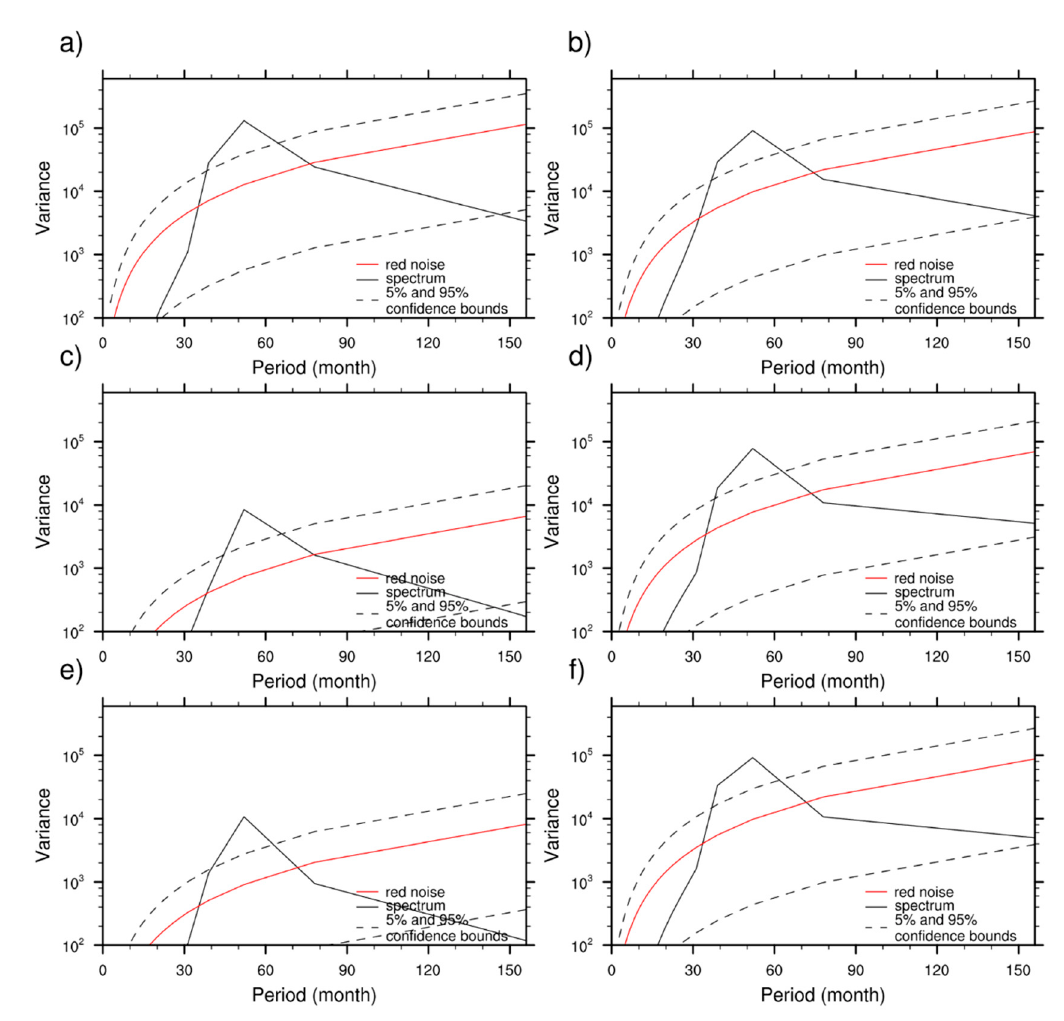
Figure 8. Spectra for bandpass-filtered first EOF time series of SST from the ERA5 dataset ( a ) and selected models (red line is the red noise, and dashed line is the 5% and 95% confidence bounds). Models ( b – f ) are the same as Figure 6 ( b – f ).